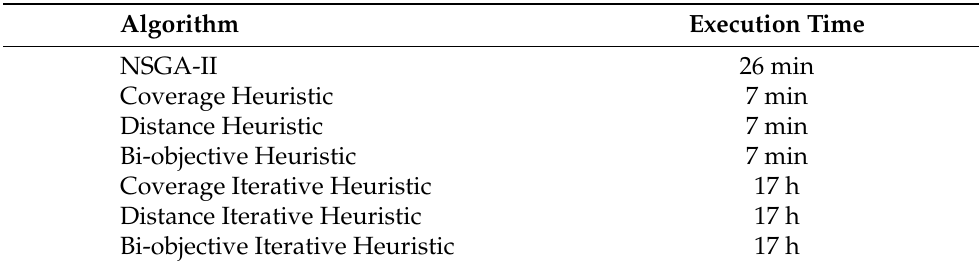
Table 9. Execution time for NSGA-II and heuristic algorithms on MU1. The measured time depicts the execution time each algorithm takes to locate 100